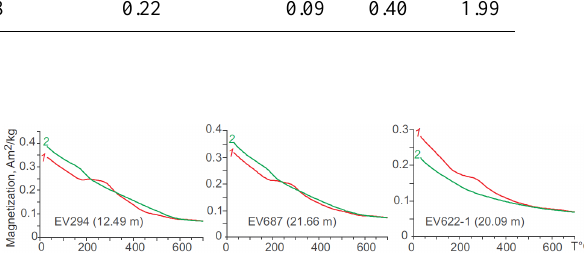
Fig. 8. Induced magnetization versus temperature curves of repre- sentative vivianite samples. Cursive numbers show the heating